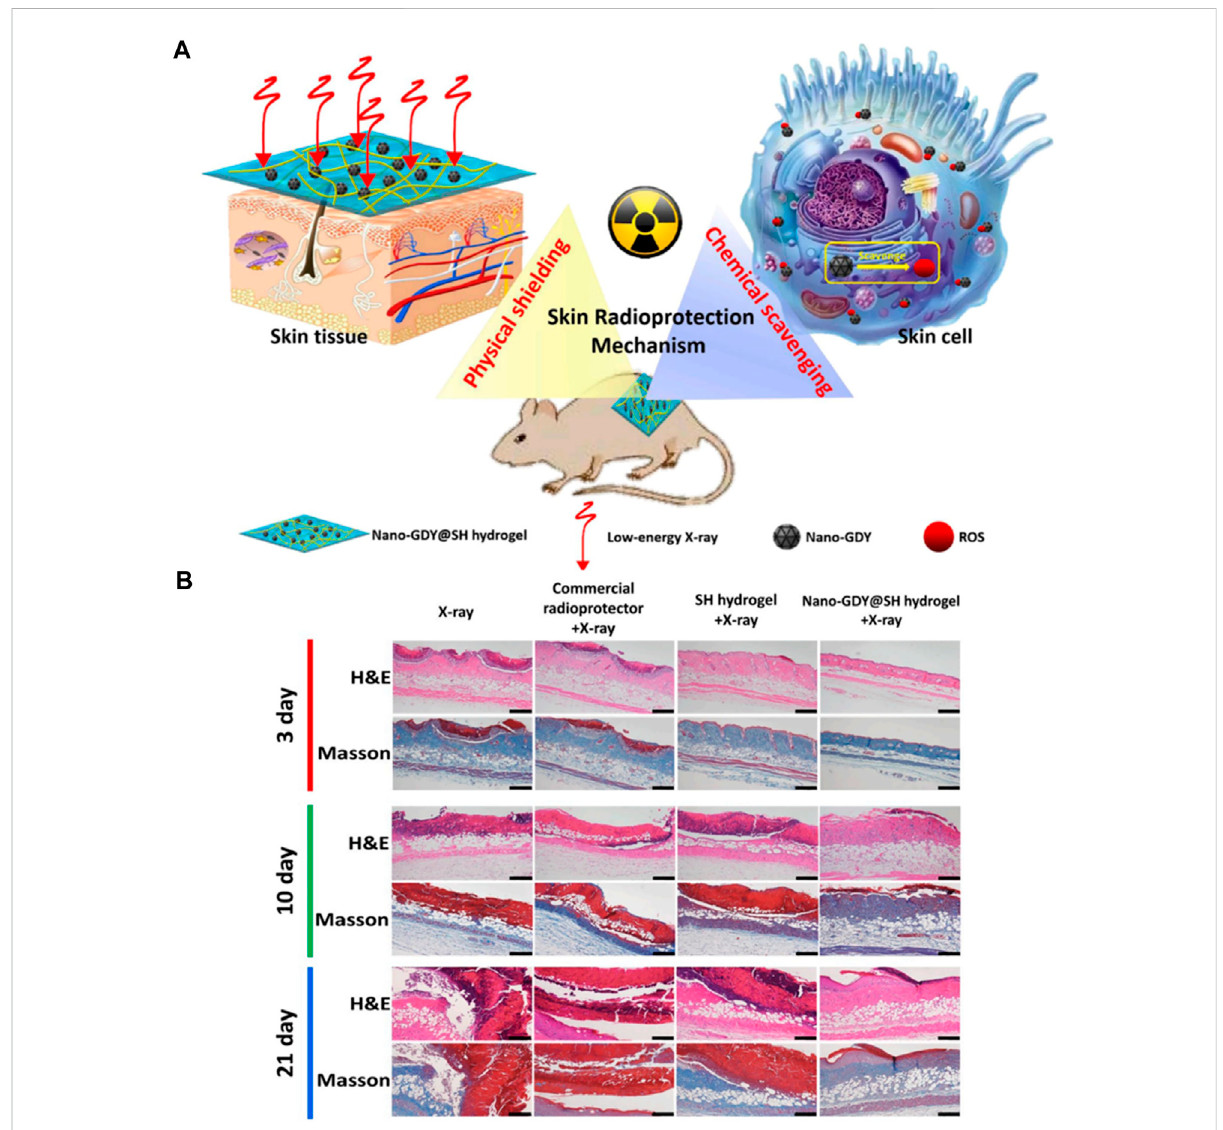
FIGURE 4 External use of the hydrogel for skin radioprotection via both physically shielding of Low-energy X-ray and chemically scavenging of Broad- spectrum free radicals. (A) The scheme of skin radioprotection by nano-GDY@SH hydrogel via both physically shielding of low-energy X-ray and chemically scavenging of broad-spectrum free radicals. (B) The histopathology analysis of skin tissue of mice after different treatments by H&E and Masson staining. Scale bar: 100 μ